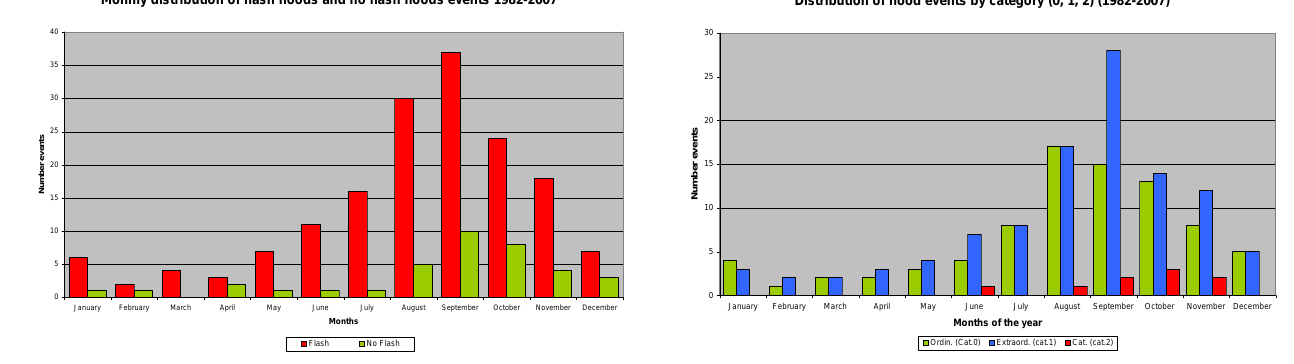
Figure 7. Monthly distribution of floods in Catalonia taking into account their Fig. 7. Monthly distribution of floods in Catalonia taking into ac- impact (1982-2007) count their impact (1982–2007).